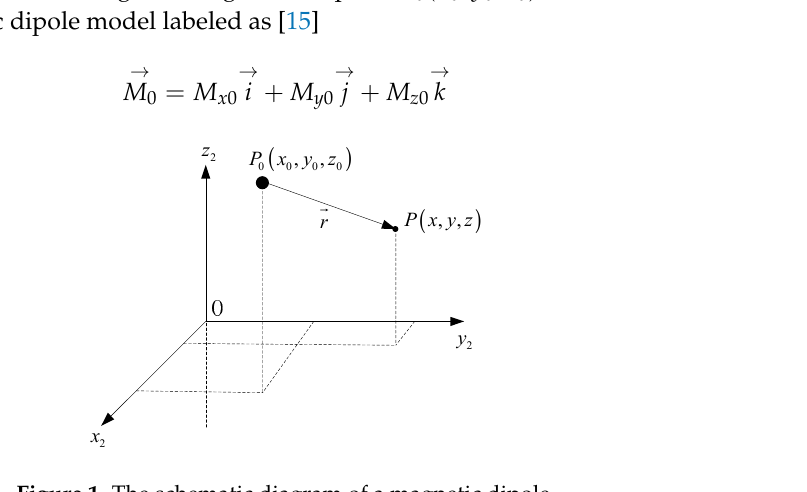
Figure 1. The schematic diagram of a magnetic dipole.